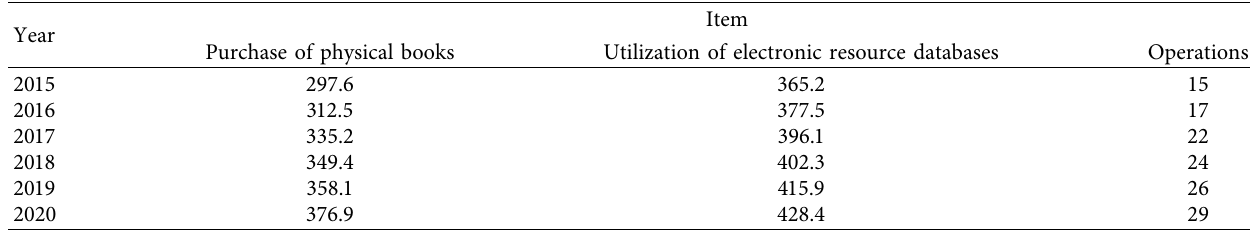
Table 2: Financial cost of libraries in 2015–2020.